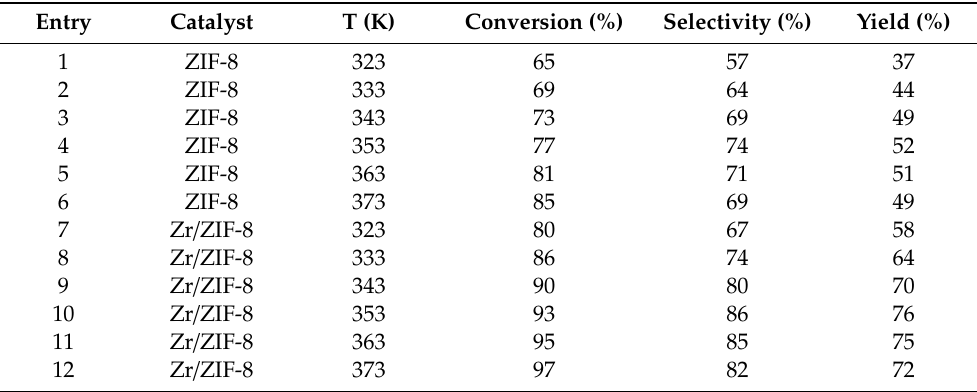
Table 2. Summary of catalytic performance of ZIF-8 and Zr / ZIF-8 for coupling reaction of CO 2 and epichlorohydrin to produce chloromethyl ethylene